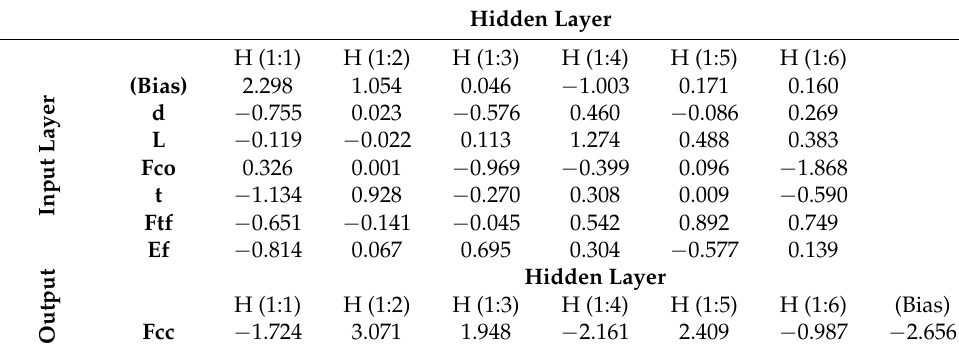
Table 3. Matrix of weights for ANN — BP network.